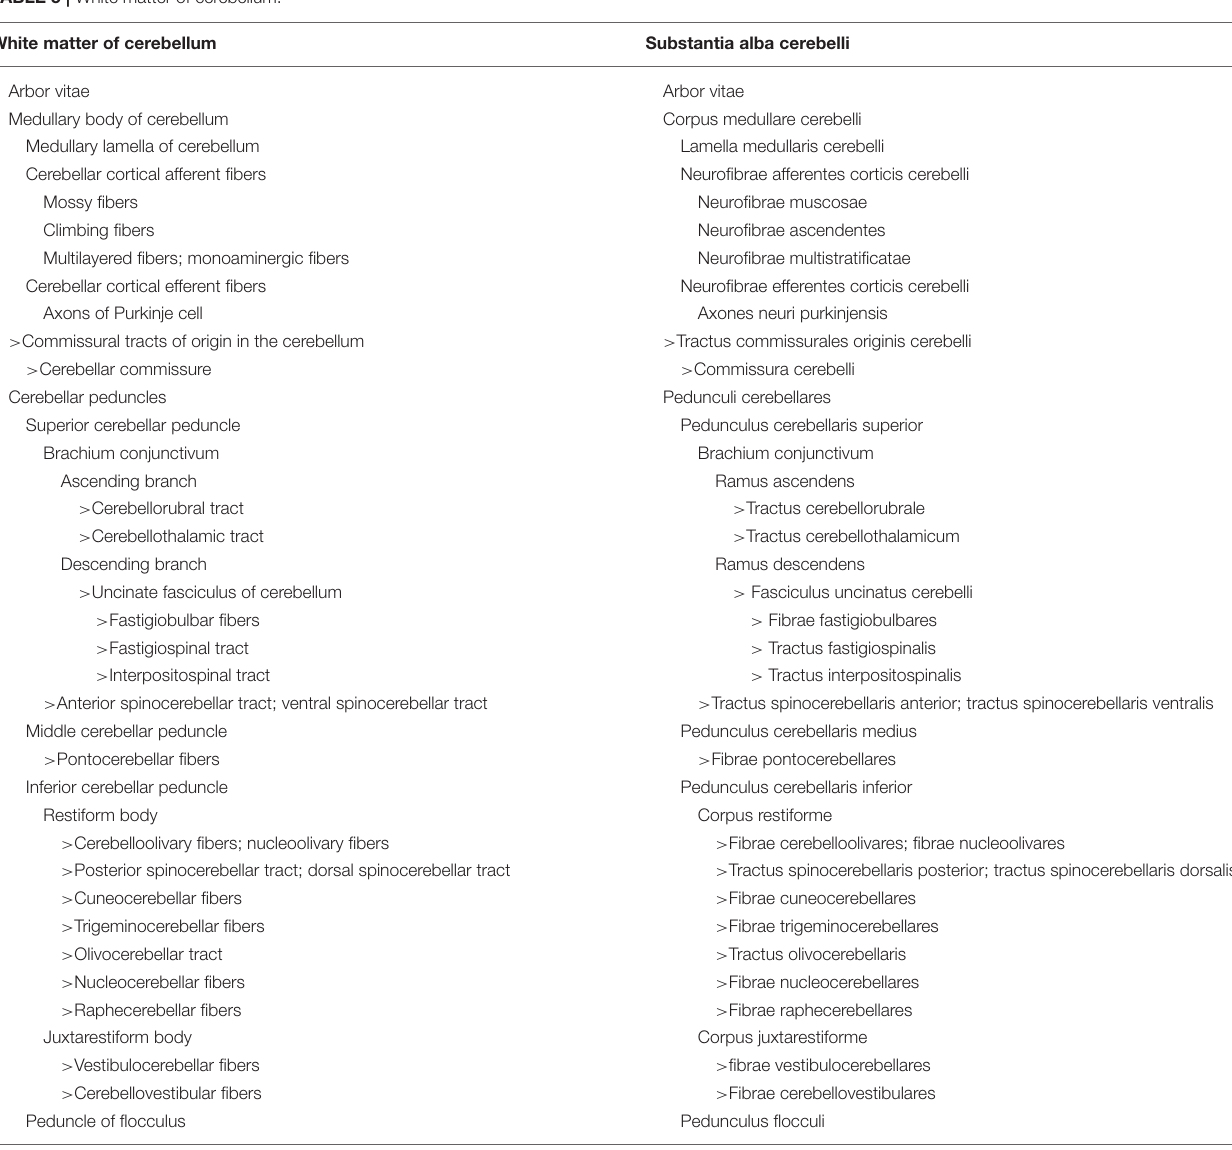
TABLE 5 | White matter of